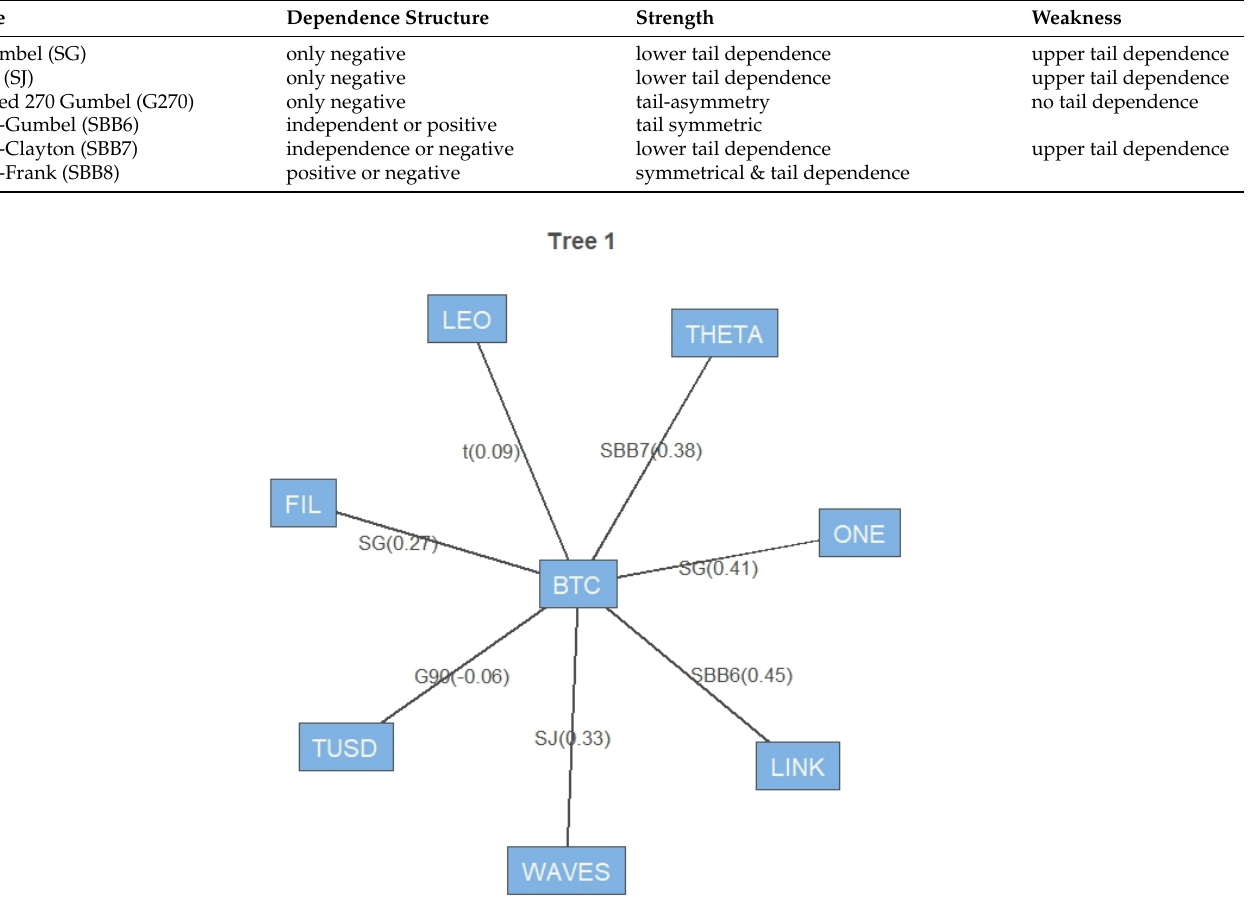
Figure 5. C-vine tree